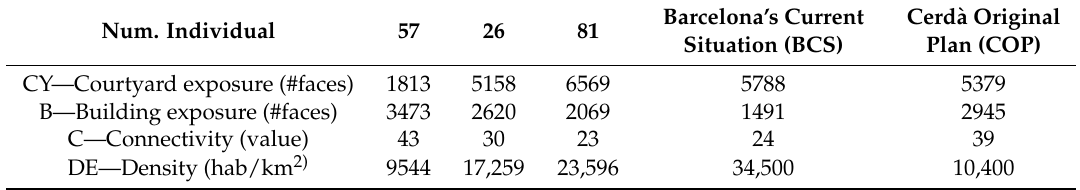
Table 3. Selected individuals based on Fitness Average compared to current and original state. Num. Individual